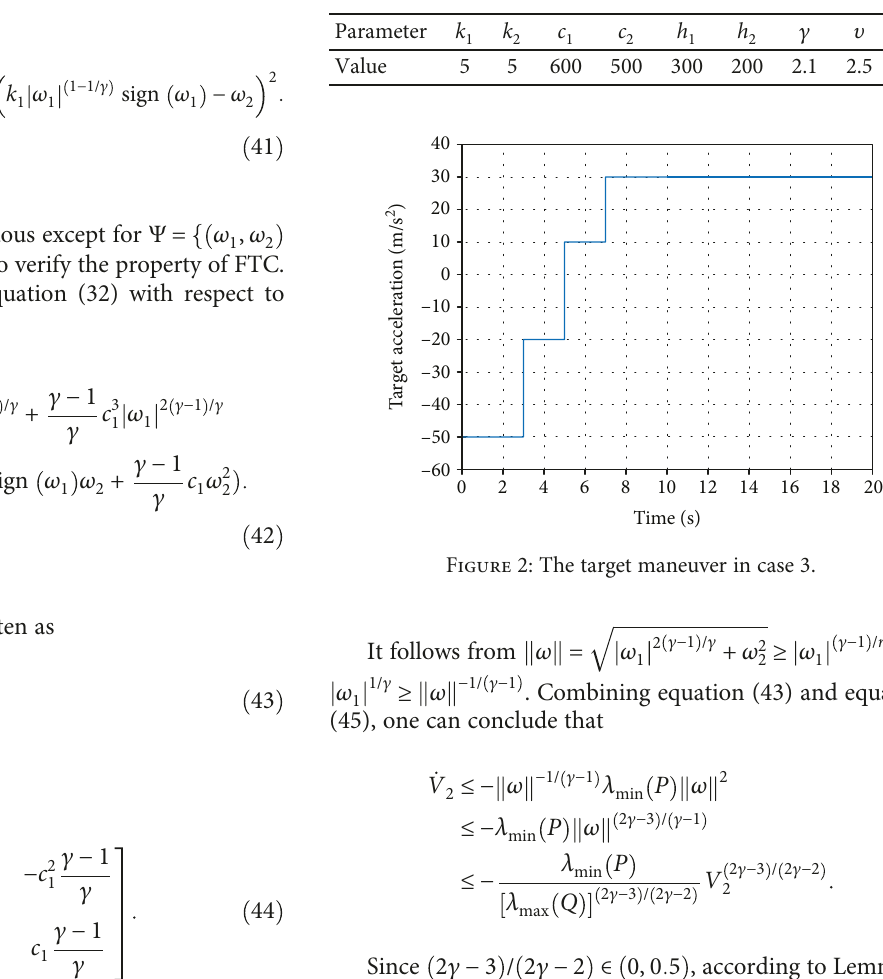
Table 1: Values of the design parameters.